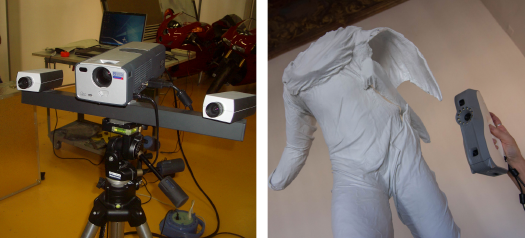
Figure 4. Triangulation laser scanner with